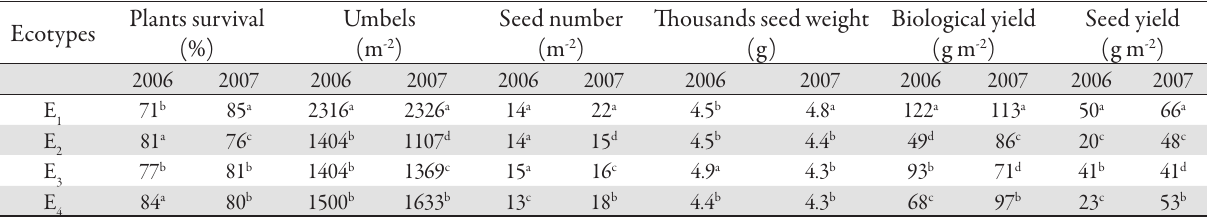
Tab. 3. Effects of different ecotypes of cumin ( Cuminum cyminum L.) on plant survival, number of umbelest, seed number, thousand seed weight, biological and seed yield